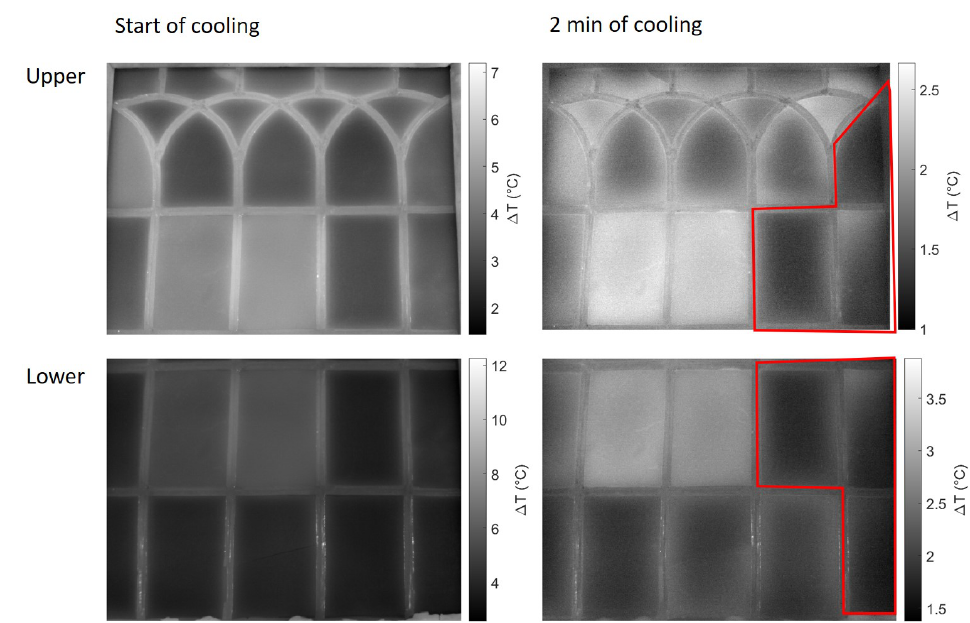
Figure 3. Refection mode thermograms of the upper ( top row) and lower parts ( bottom row). The left column shows the window at the start of cooling, the right column after 2 min of cooling. The upper and lower images have one row of glass panes in common. Two types of glass can be discerned in the image before cooling, while the red line indicate a possible third group that emerges in the image during cooling. The temperature difference is measured with respect to the average cold frame.